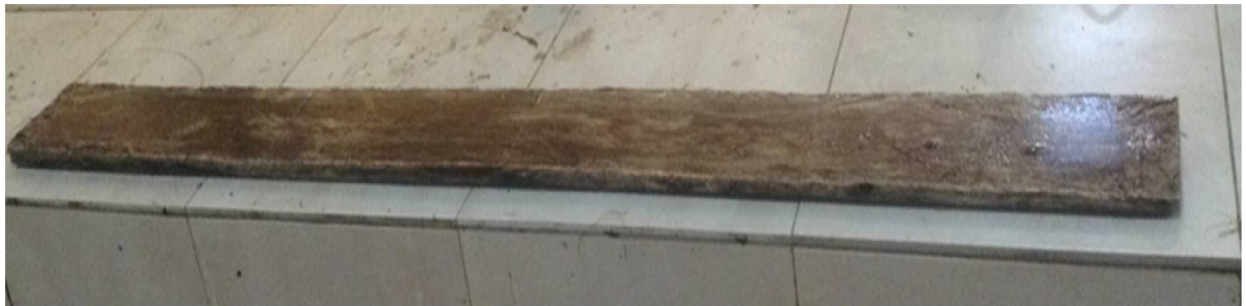
Figure 1. Process of fabricating bamboo fiber laminate.